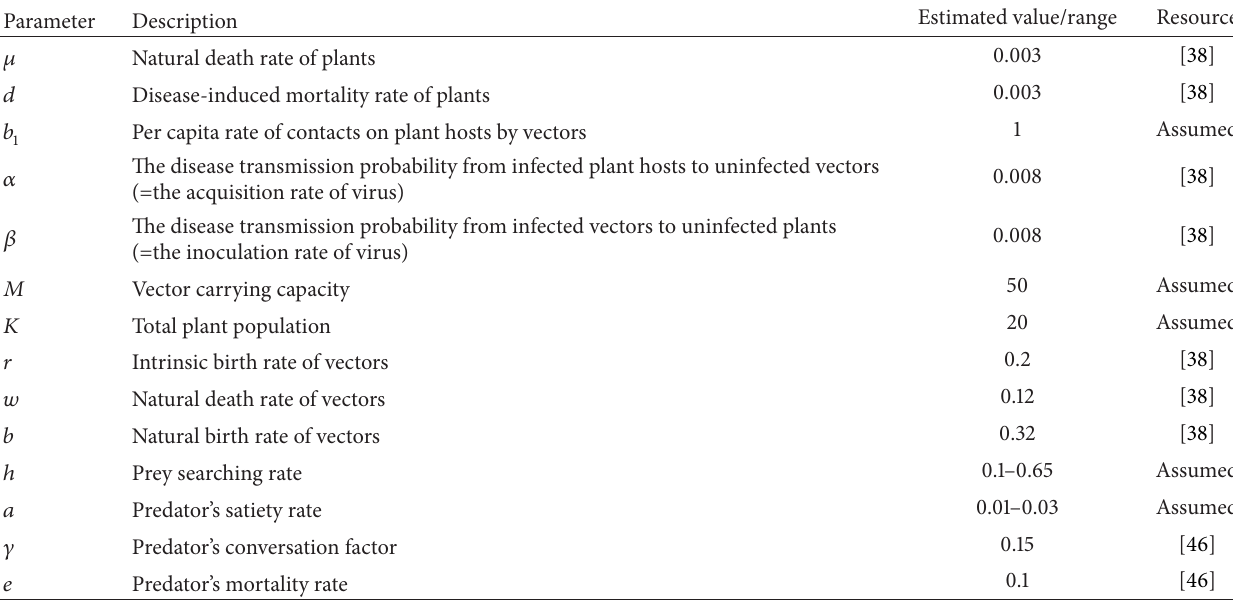
Table 1: Definition of parameters and values used in simulations (time unit is selected as